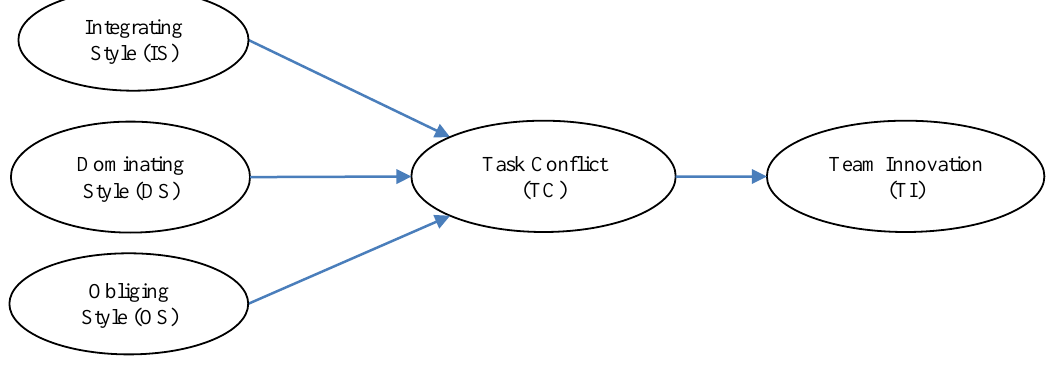
Figure 1. The proposed research